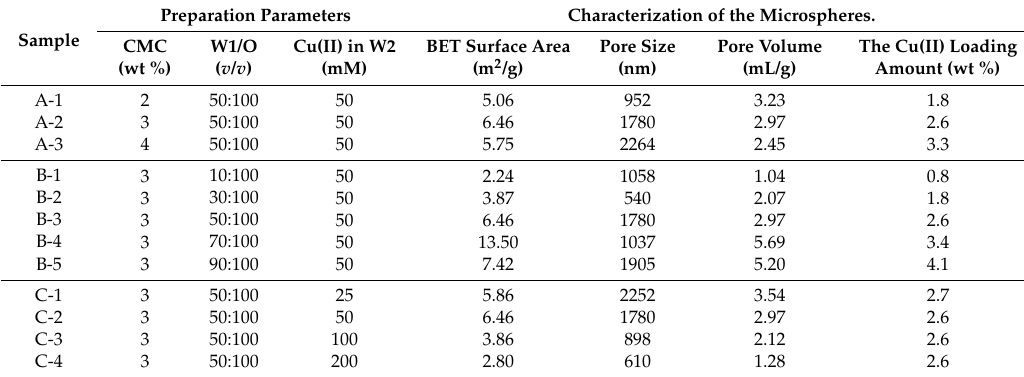
Table 1. Preparation parameters and characterization of the microspheres